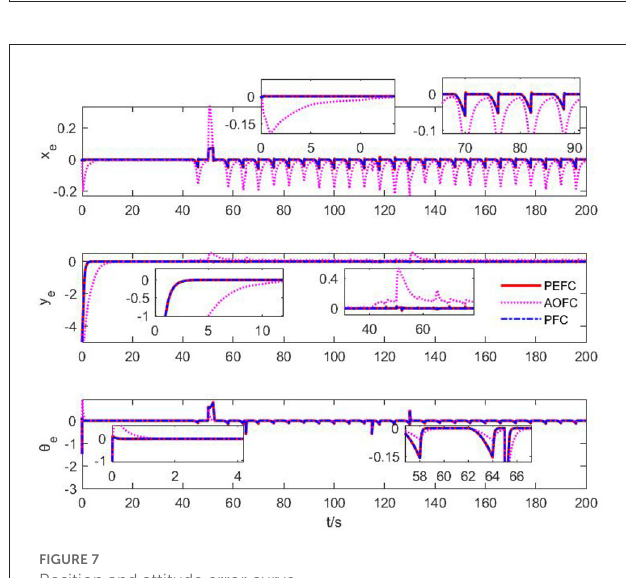
FIGURE7 Position and attitude error